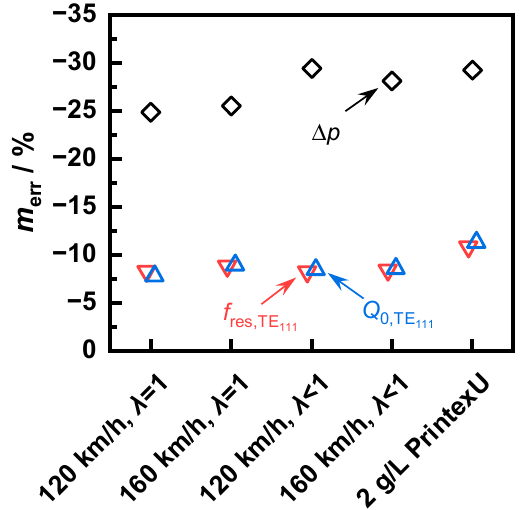
Figure 10. The proportional error of the Δ p and the RF sensors (evaluation of the resonant mode TE 111 ) after the end of the first regeneration.